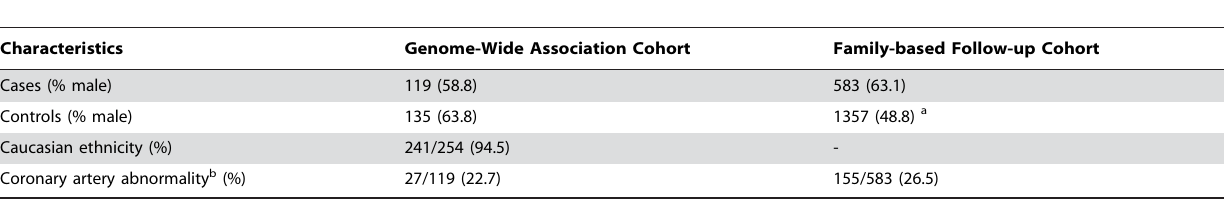
Table 1. Demographic and Clinical Characteristics of Subjects in the GWAS (Dutch Case-Control Samples) and Replication Study (Australian, US And UK